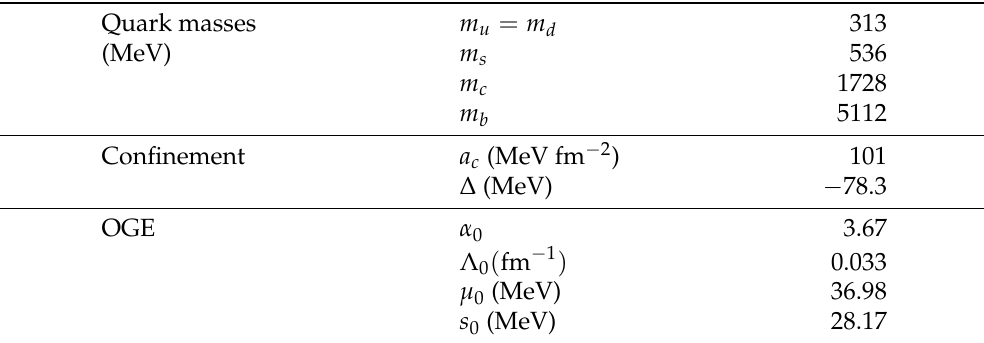
Table 1. Model parameters, determined by fitting the meson spectrum from light to heavy.